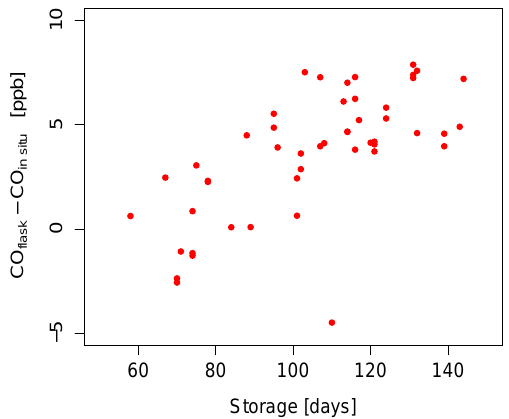
Figure 9. Evidence for a carbon monoxide storage-related artifact. CO flask is the average flask measurement, CO insitu is the corre- sponding average of the continuous measurements from the OA- ICOS. The difference between the two determinations is plotted as a function of storage time from sampling to measurement.